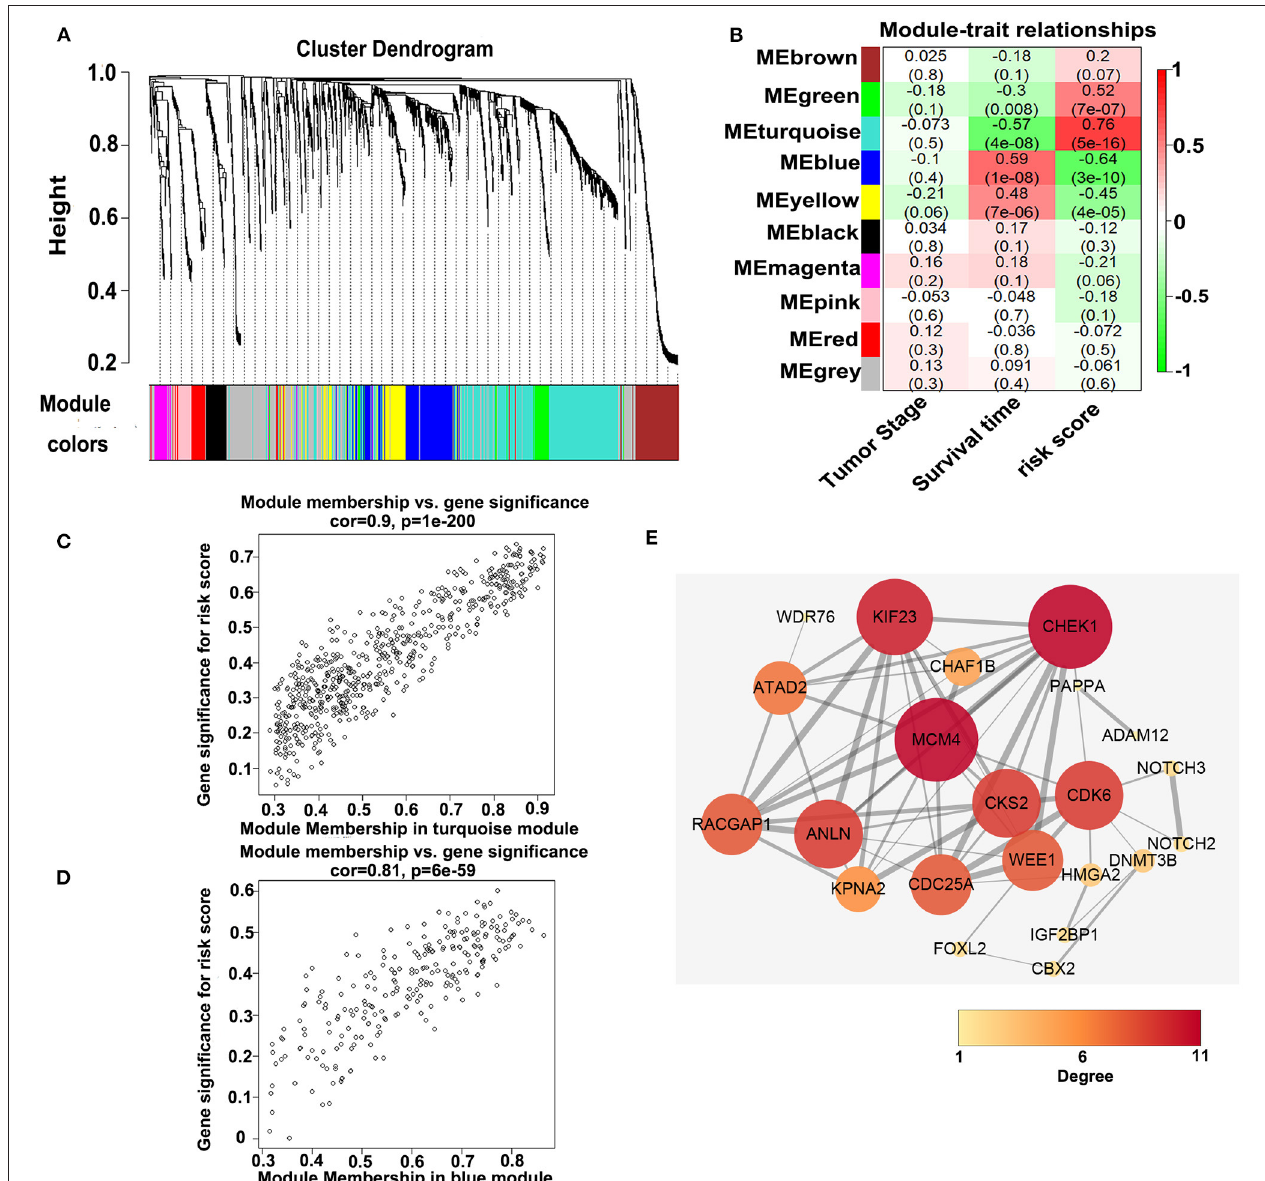
FIGURE 8 | WGCNA analyses of the DEmRNAs. (A) Identification of the co-expression modules. (B) Association between the modules and the traits. (C) Pearson correlations between the genes in the turquoise module and the risk score. (D) Pearson correlations between the genes in the blue module and the risk model. (E) Protein–protein interaction network analysis of the overlapped mRNAs in the ceRNA network and the turquoise module. The size and color of the round represent the number of links of the protein